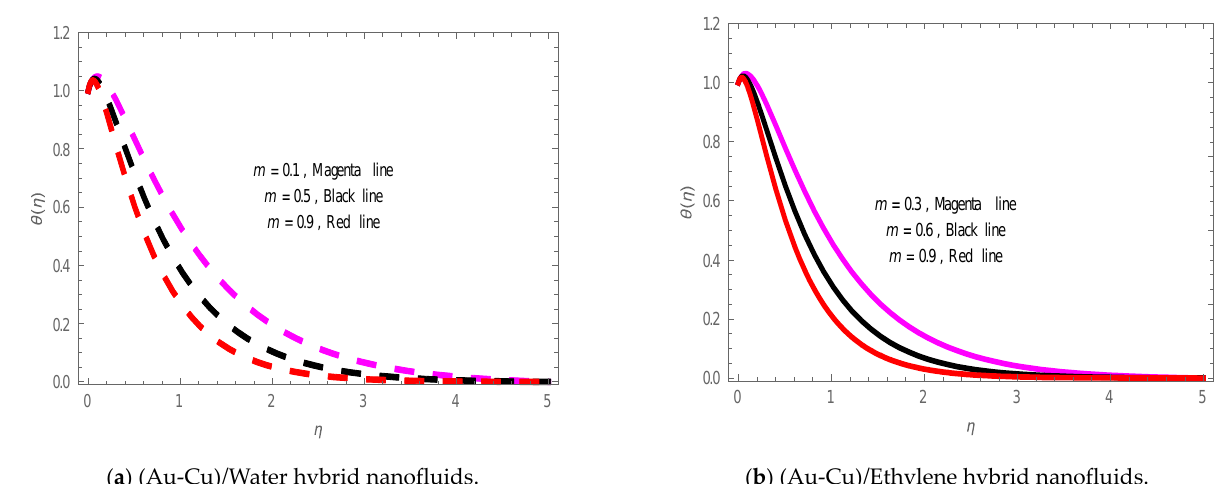
Figure 9. θ ( η ) for dissimilar values of M . Figure 9. 𝜃(𝜂) for dissimilar values of M. Figure 9. 𝜃(𝜂) for dissimilar values of M.